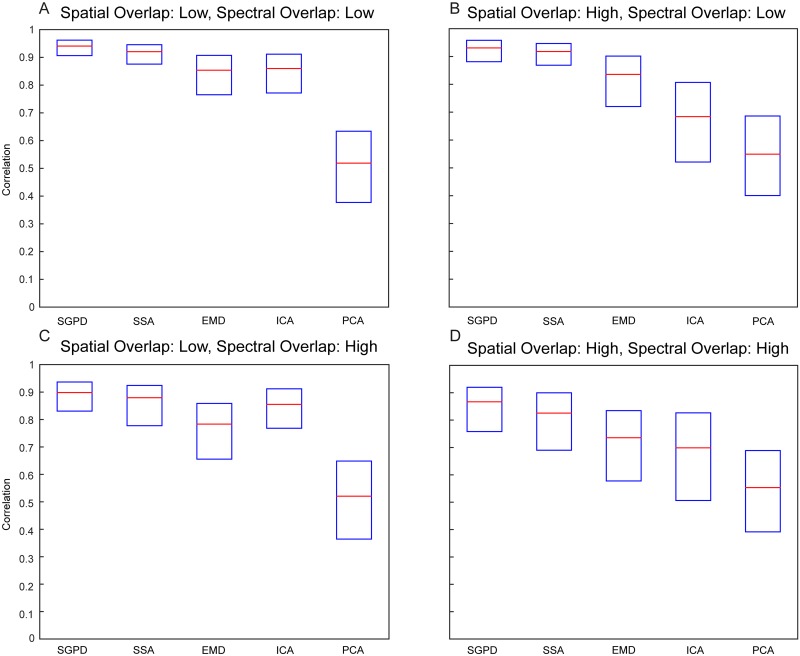
Simulation results on the decomposition of spatiotemporally mixed signals.Performance of SGPD, SSA, EMD, ICA and PCA in recovering an oscillatory signal that was mixed with complex spatiotemporal noise. The performance is quantified as correlation with the ground truth. The red line is the median correlation across trials, the boxes contain correlations between the first and the third quartile. There are four conditions: A) low spectral and low spatial overlap; B) high spectral and low spatial overlap; C) low spectral and high spatial overlap; D) high spectral and high spatial overlap.